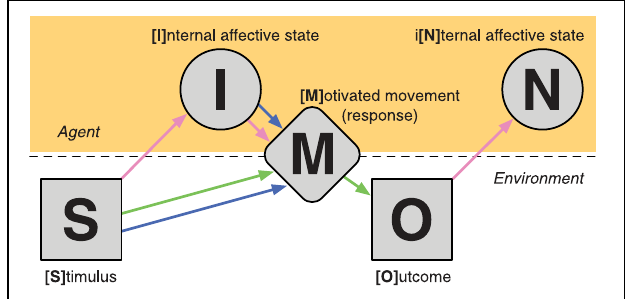
FIGURE 2 | Illustration of the processes involved in the SIMON framework. Line arrows correspond to the portions of the framework that are intrinsic to each of the three component constructs: reward (green), affect (pink), and motivation